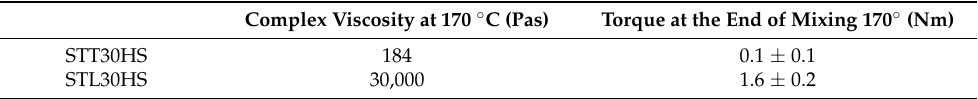
Table 3. A comparison of the complex viscosity and torque at the end of the mixing process for two different SEBS composites with 30 vol.-% CIP.